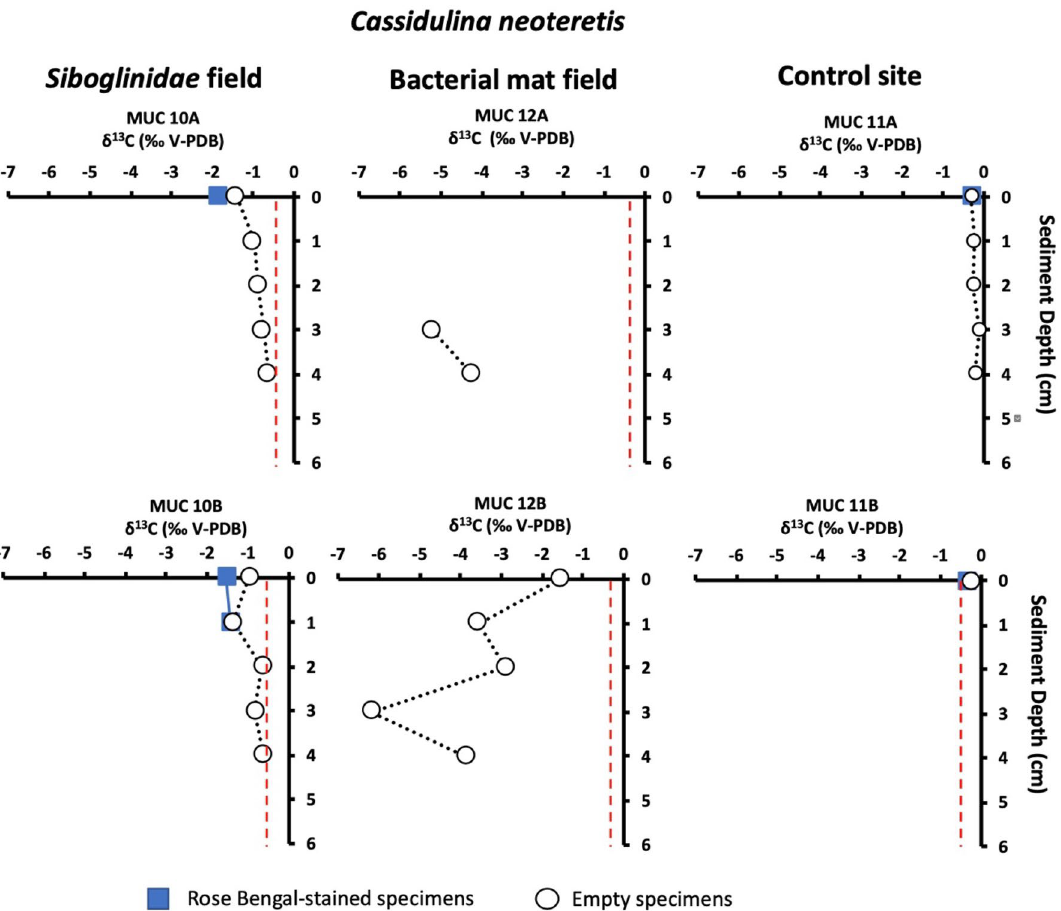
Figure 4. Carbon isotope values (δ 13 C) of Cassidulina neoteretis in sediment from the Siboglinidae field (MUC 10A and MUC 10B), bacterial mat field (MUC 12A and MUC 12B), and control site (MUC 11A and MUC 11B). The vertical red line indicates the δ 13 C minimum value for conditions 34